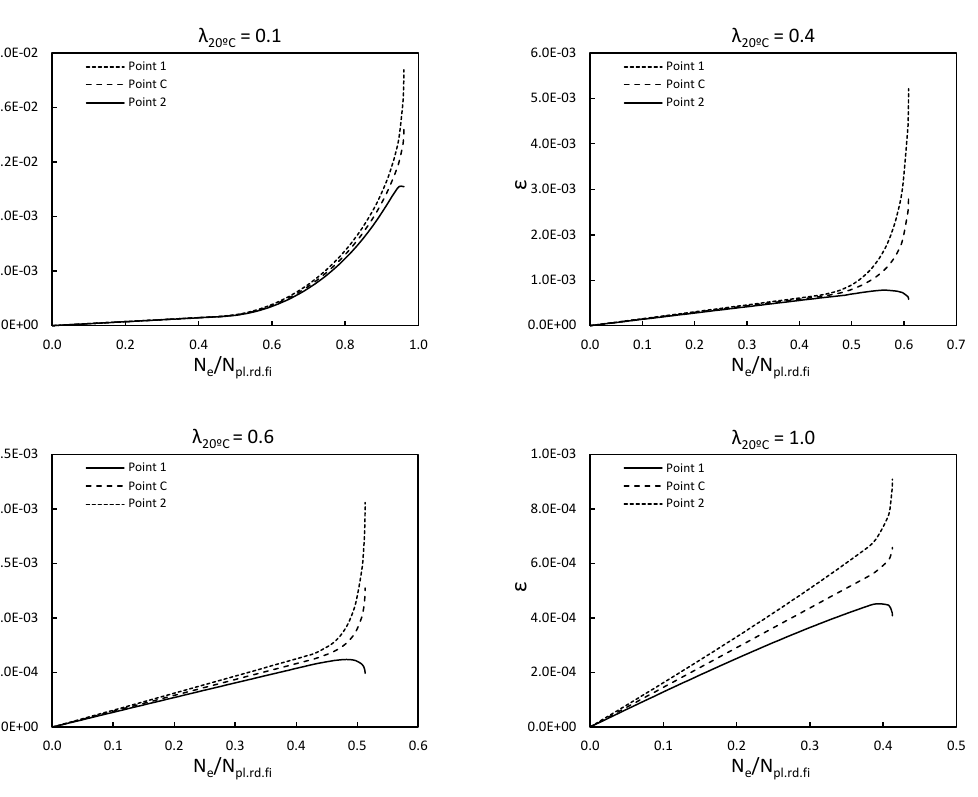
Figure 4. Mid-height section strain paths for RHS160x6 S355 with different slenderness ratios at θ = 500 °C.